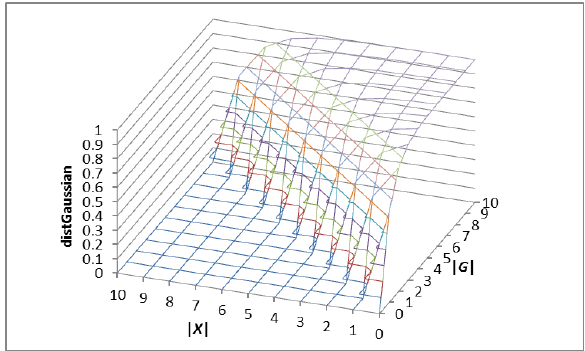
Figure 3: dist Gaussian (︀ X t , G k )︀ against the magnitude of two vectors of interest, assuming the directionality of the two vectors is the same. (Plotted for |G|>|X| only for clarity.)